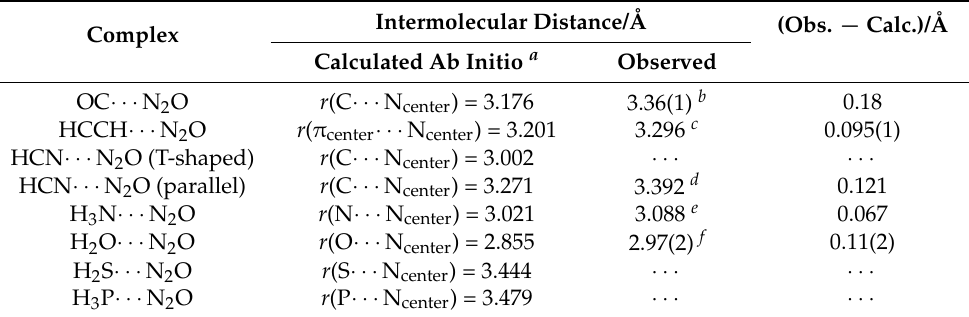
Table 2. Calculated and observed intermolecular distances in B · · · N 2 O complexes. Intermolecular Distance/Å (Obs. − Calc.)/Å Complex Calculated Ab Initio a